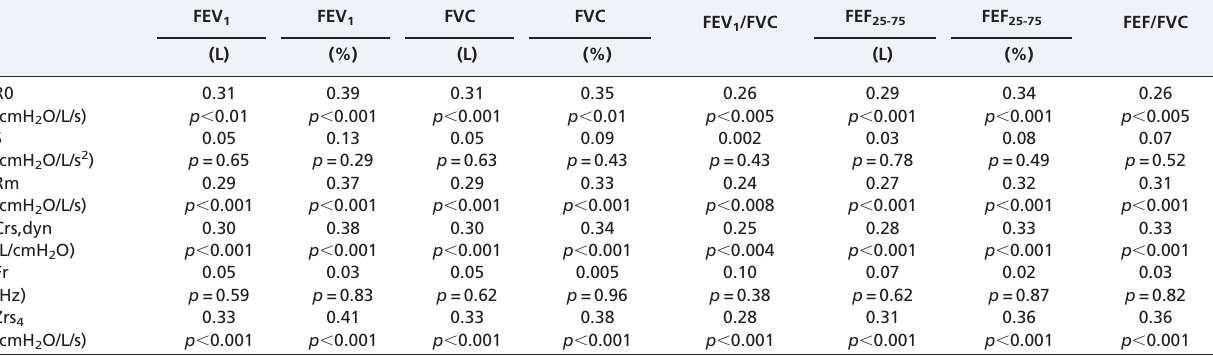
Table 3 - Comparisons of AUC among oscillometric and spirometric parameters (AUC FOT - AUC spirometry ). Positive values indicate higher area in FOT